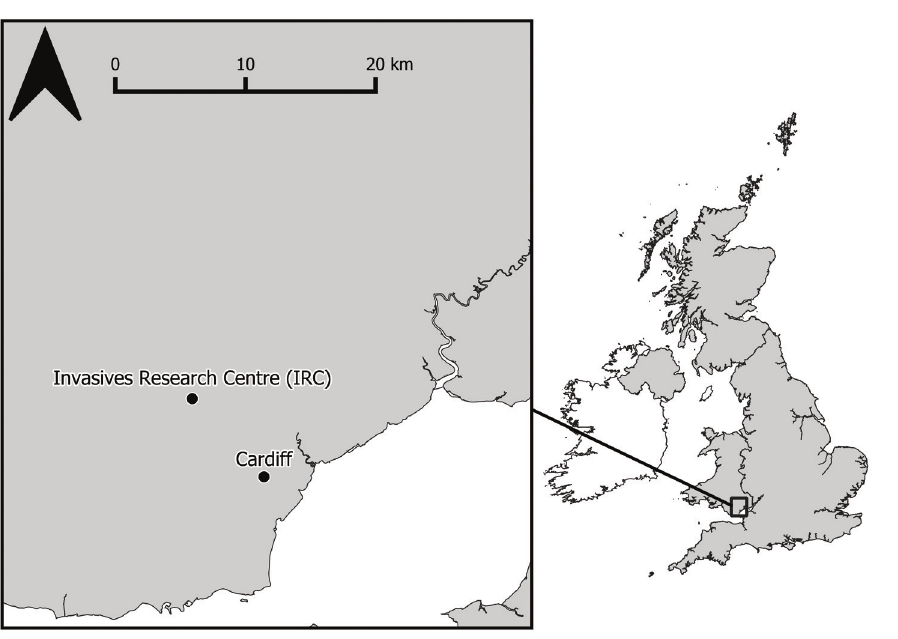
Figure 3. Map of the study area. Inset shows location of Invasives Research Centre (IRC) in south Wales, UK (WGS 84: 51.534124,